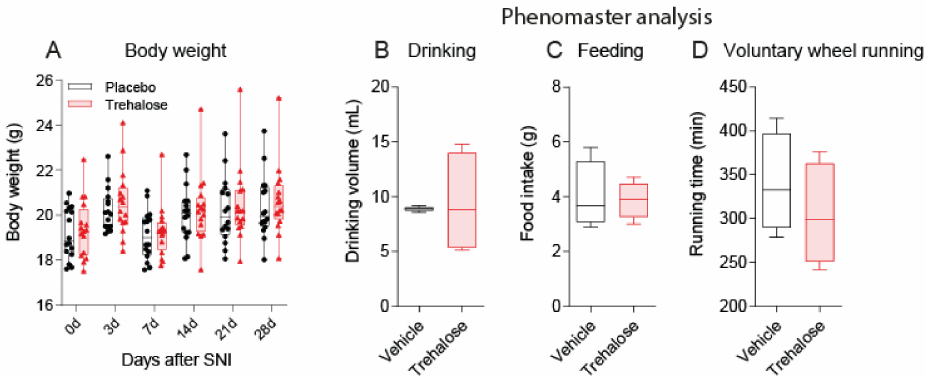
Figure 1. Body weights and Phenomaster analysis. ( A ): time course of body weights after Spared Nerve Injury (SNI). Two-way ANOVA showed no differences between the treatment groups. The scatters show individual mice ( n = 16 per group). ( B ): Phenomaster analysis of the 24 h drinking volume. ( C ): Phenomaster analysis (7 weeks after SNI) of 24 h feeding. ( D ): Phenomaster analysis of voluntary wheel running (VWR). The box shows the interquartile range, the line the median, and the whiskers the 10th–90th quantile, ( n = 8 per group). Data were compared using unpaired, 2-tailed Student’s t